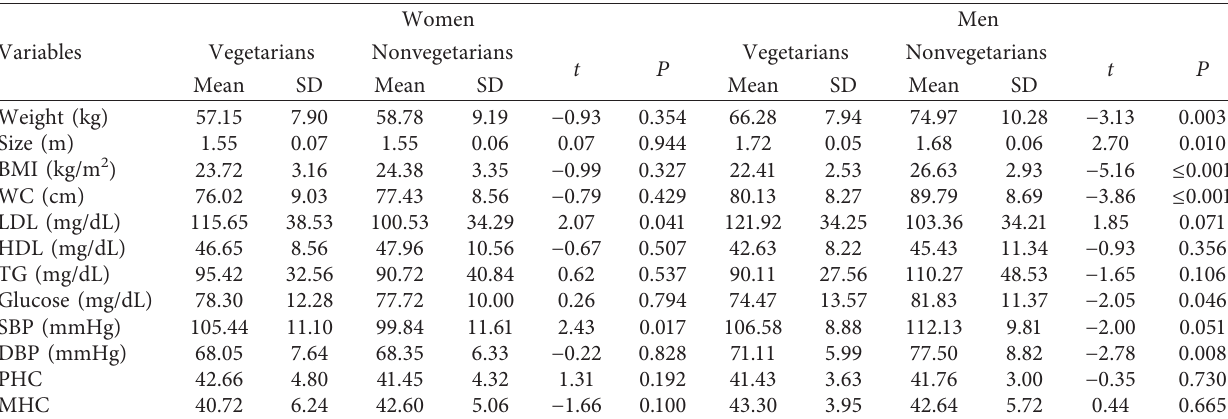
Table 2: Comparative analysis of anthropometric, biochemical, and quality of life data for vegetarians and nonvegetarians by gender. Variables